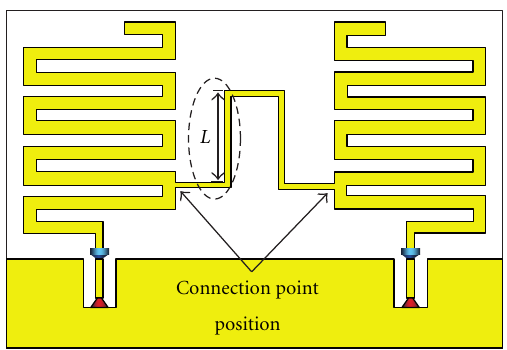
Figure 4: Simulation model with varied connection line length L of the MIMO antenna system